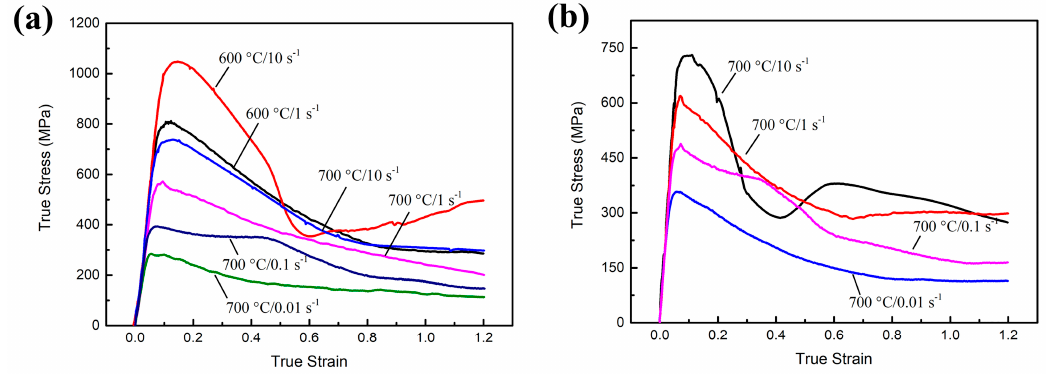
Figure 8. Flow curves of the PM and the IM Ti-5553 alloy at various conditions: ( a ) PM alloy at 600 °C and 700 °C; and ( b ) IM alloy at 700 °C.